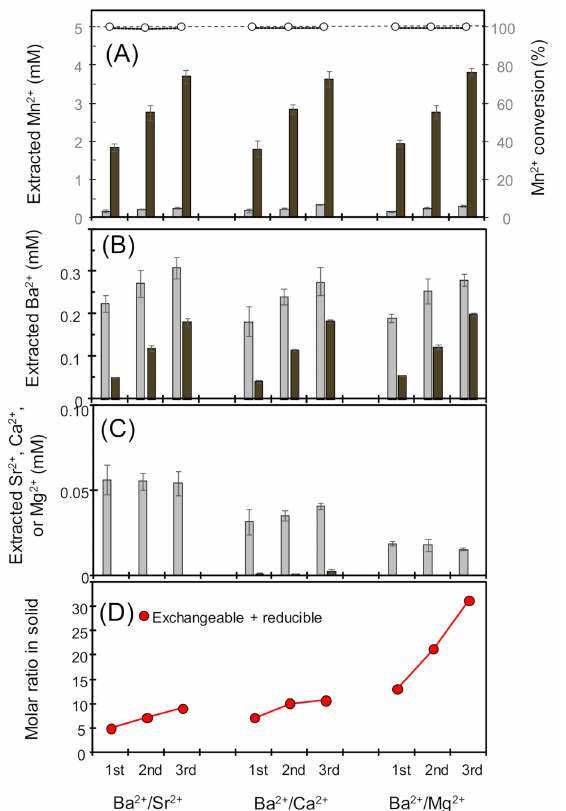
Figure 8. Diagram showing the two-step extraction of ( A ) Mn; ( B ) Ba; and ( C ) Sr, Ca, or Mg from the newly formed biogenic manganese oxides during repeated treatments with mixed solutions of 1 mM Ba(NO 3 ) 2 and 1 mM Mn(NO 3 ) 2 in 20 mM HEPES (pH of 7.0) with 1 mM Sr(NO 3 ) 2 , Ca(NO 3 ) 2 , or Mg(NO 3 ) 2 . The bathing solutions were renewed thrice every 24 h. ( D ) Plot of the Ba/Sr, Ba/Ca, and Ba/Sr molar ratios in the solid phases demonstrating sequestration